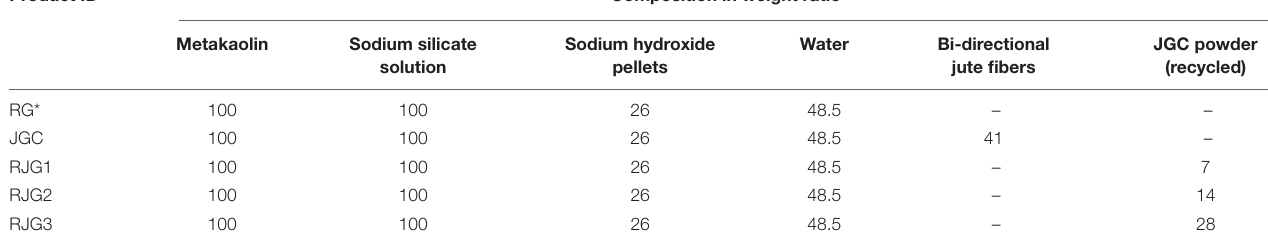
FIGURE 1 | Bi-directional jute fibers. TABLE 1 | Composition of